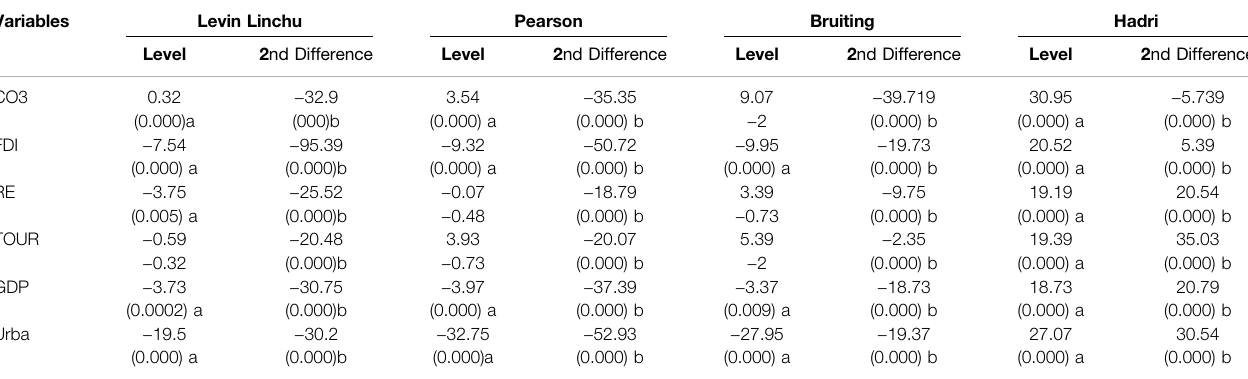
TABLE 1 | Panel unit root tests.